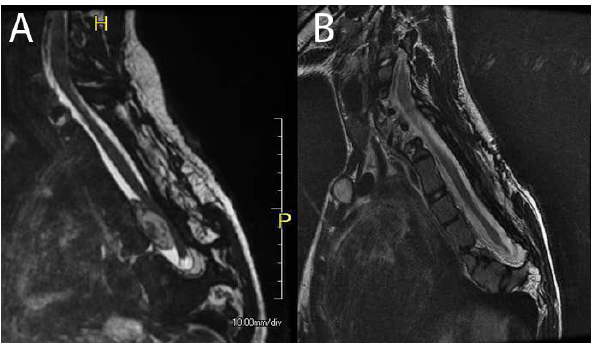
Figure 1. A – Preoperative MRI on sagital view showing the tumor anterior to spinal cord. B -Postoperative MRI showing